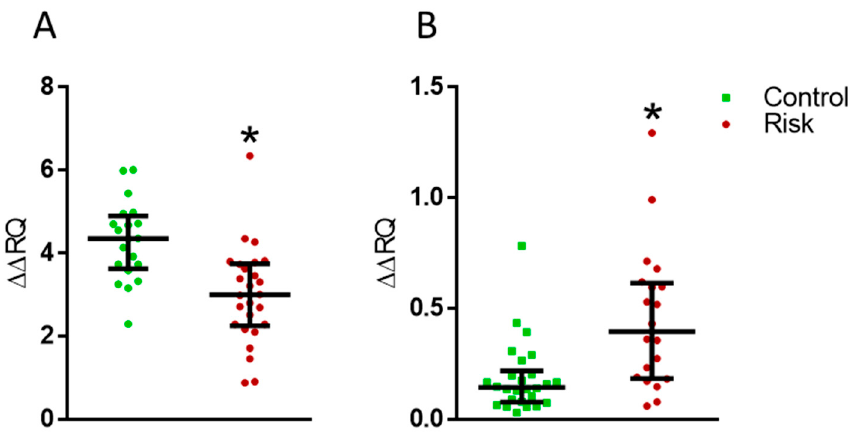
Figure 10. ( A ) Changes in the PARK7 gene expression in the patients at risk of developing Parkin- son’s disease compared with the controls. ( B ) Changes in the LAG3 gene expression in the patients at risk of developing Parkinson’s disease compared to controls. ∆∆ RQ, the change in gene expression normalized to the housekeeping gene. * p < 0.05, statistically significant differences. Data presented as a median with an interquartile range and min–max values.